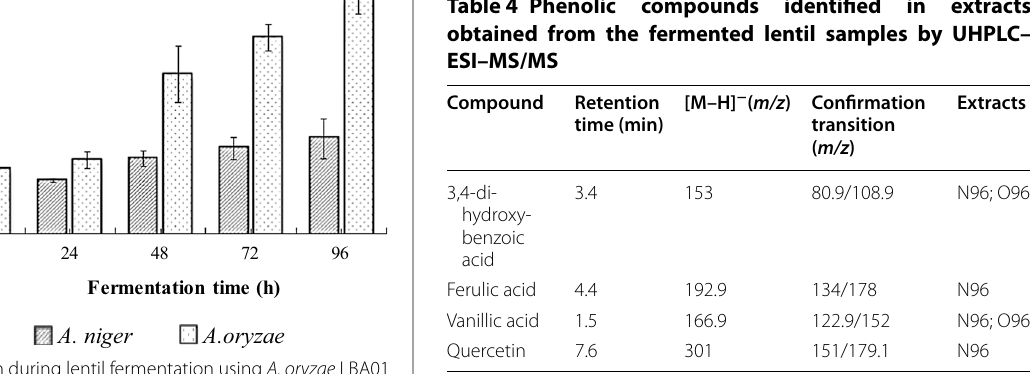
Table 4 Phenolic compounds identified in